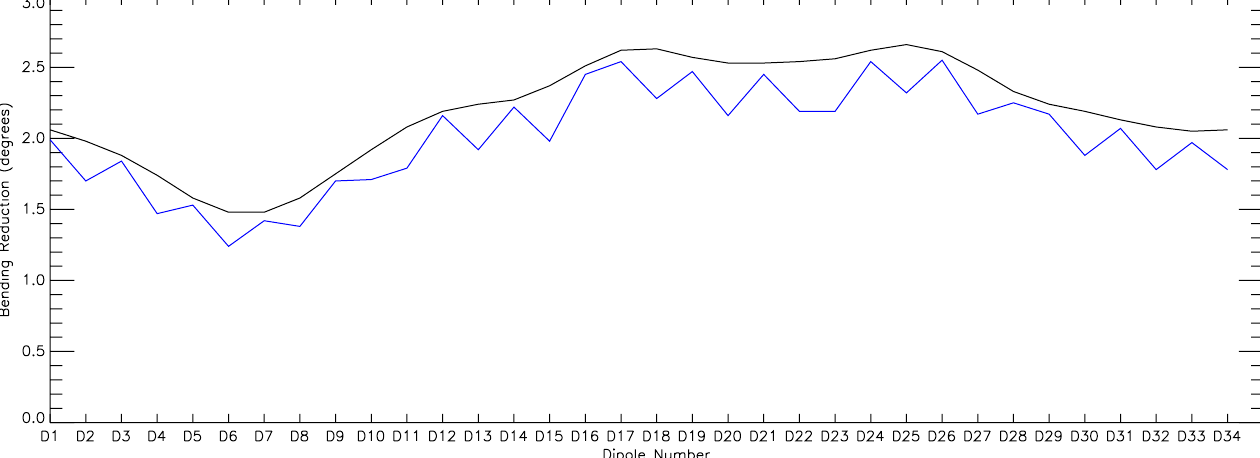
FIG. 3. (Color) A comparison of values for the ring steering. In order to account for the earth’s magnetic field, the ring bending dipoles must be altered from their physical bending setting of 10 degrees. This is a plot of that change. The black line is the previous method of reducing the dipole currents by the amount equal to the equivalent of the integrated magnetic field over the section. The blue line is the result of having COSY INFINITY steer the beam to the center of the pipe with zero angle at the end of each focusing-defocusing (FODO) section. We attempted to smooth out the settings but every attempt made the steering significantly